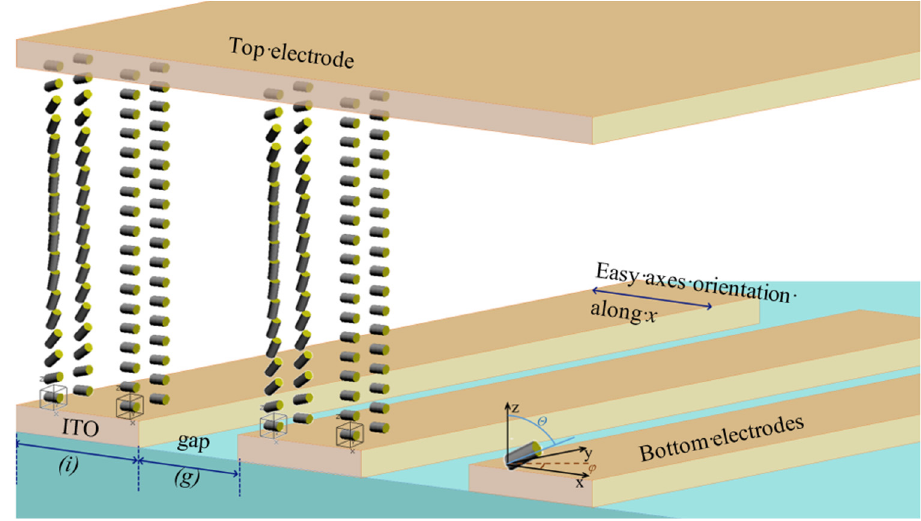
Figure 3. Visualization of the modeling results of LC molecules for generation of a blazed grating in the LC cell with a thickness of 2.5 μ m. The initial orientation of the LC molecular was set to the x -axis which is perpendicular to the electrodes.